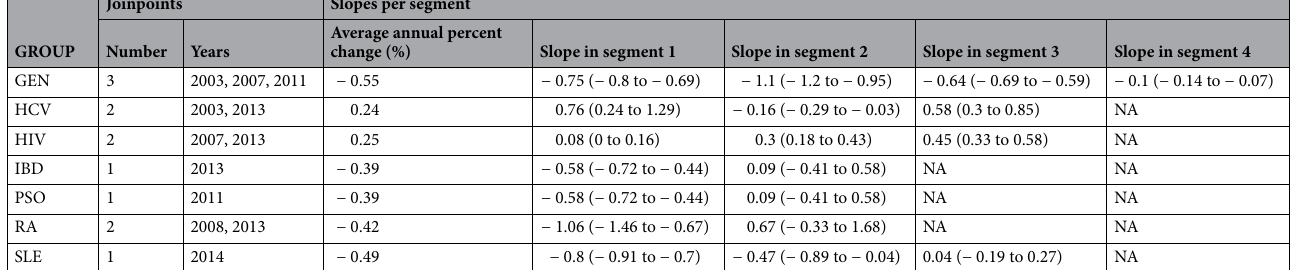
Table 2. Joinpoint regression results. GEN General population, HCV Chronic Hepatitis C Virus, ICD-10 code B18.2, HIV Human immunodeficiency virus, ICD-10 codes B20–24, IBD Inflammatory bowel disease,